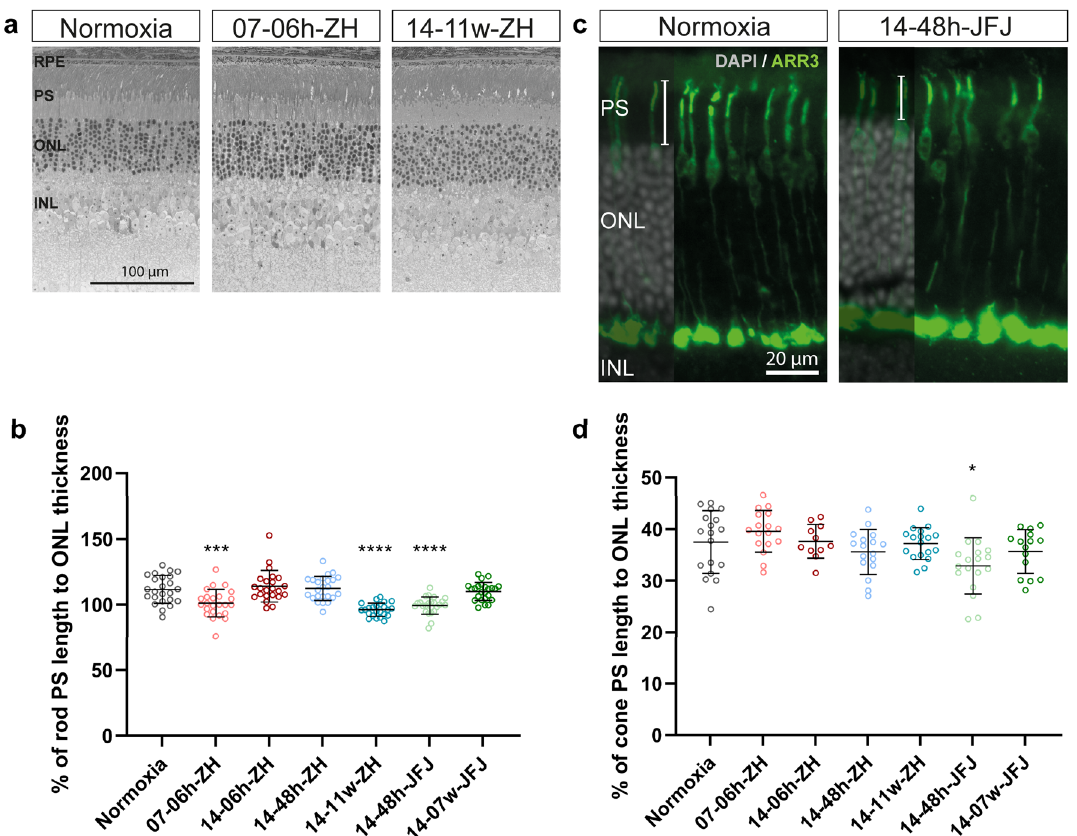
Figure 5. Photoreceptor segment lengths in hypoxia. ( a ) Representative retinal morphologies and ( b ) graph showing the ratio (%) of rod photoreceptor segment length to outer nuclear layer (ONL) thickness for indicated hypoxic conditions. ( c ) Representative immunostaining for cone arrestin (ARR3, green) and ( d ) the percentage of cone photoreceptor segment length to outer nuclear layer (ONL) thickness. Cell nuclei were counterstained with DAPI (grey). One-way ANOVA with Dunnett’s multiple comparison test was used to compare each condition to control (normoxia) * p < 0.05; *** p < 0.001; **** p < 0.0001. RPE: retinal pigment epithelium; PS: photoreceptor segments; ONL: outer nuclear layer; INL: inner nuclear layer; GCL: ganglion cell layer. Scale bars as